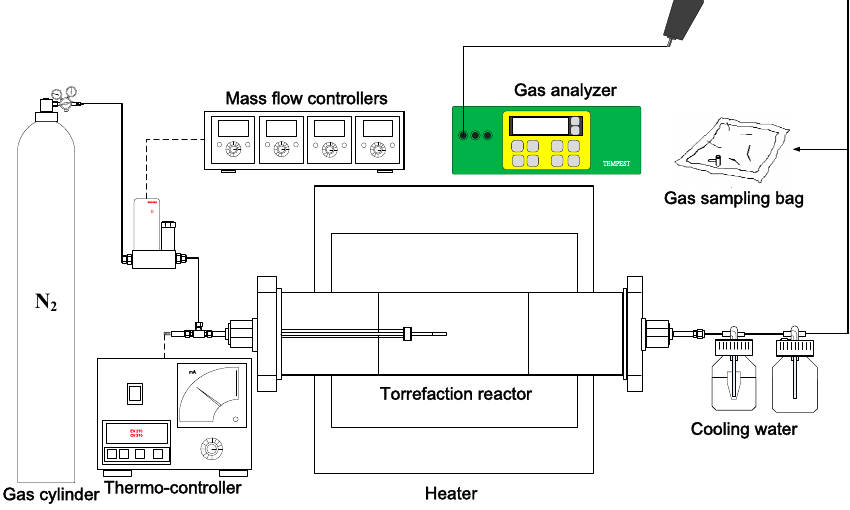
Figure 6. Schematic diagram of torrefaction system.